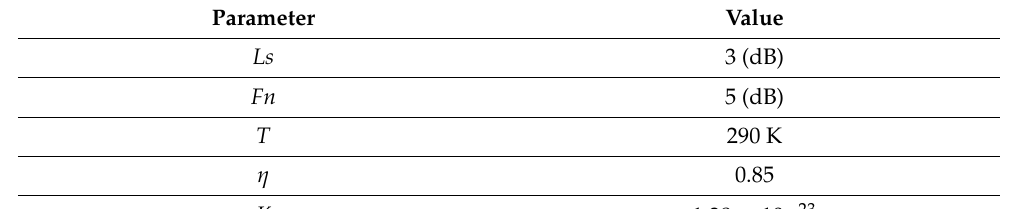
Table 4. Parameters for radar equation.